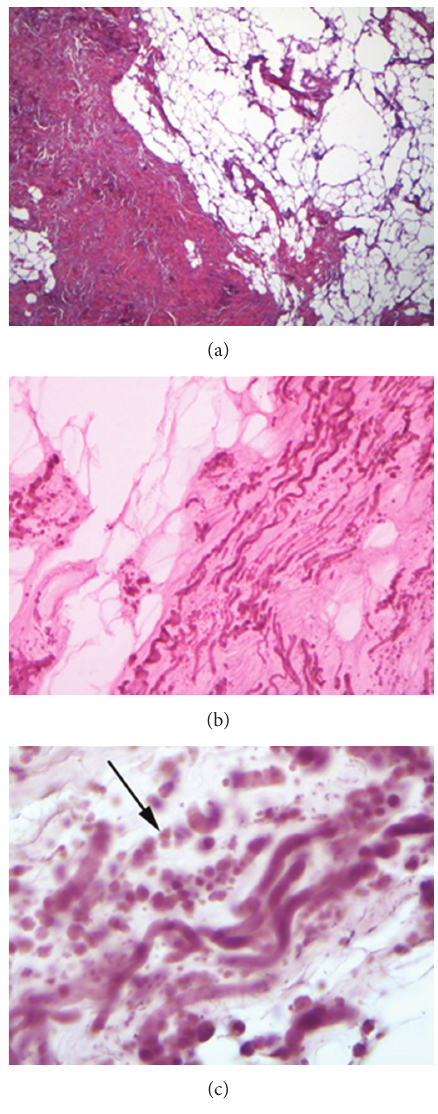
F 4: (a) A thick bundle of hypocellular collagenous tissue among fatty tissues. H�E stain. Magni�cation: 25. (b) Shikata elastic tissue stain showing the con�guration of serpentine elastic �bers. Magni�cation: 100. (c) Shikata elastic tissue stain showing × serpentine elastic �bers and broken elastic �bers arranged in a string of beads pattern (arrow). Magni�cation: × ×